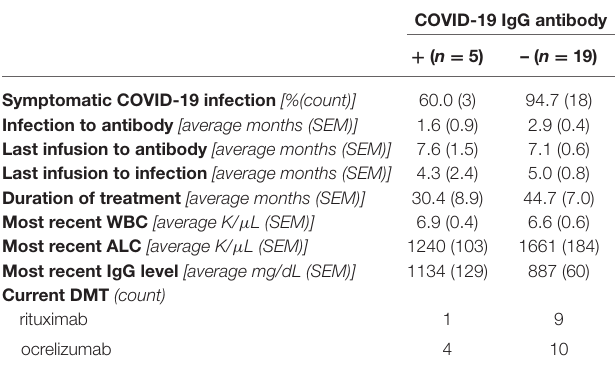
COVID-19 IgG antibody + ( n = 5) – ( n = 19)